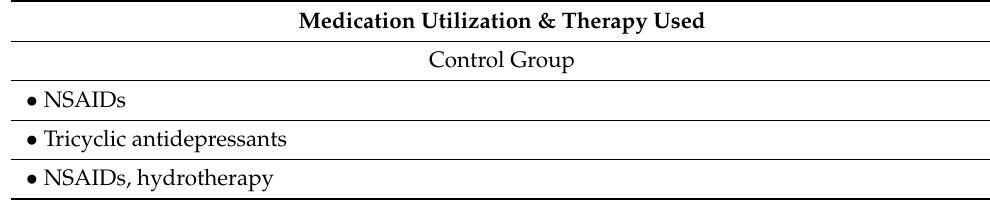
Table 5. Medication and interventional therapies utilized by of the participants in the two groups (Study Group and Control Group) tracked at the 2-year